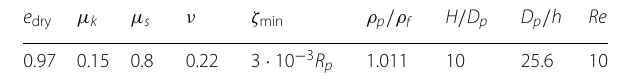
Table 3 Physical and numerical simulation parameters for simulations of shear flows with dense